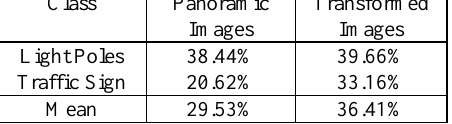
Table 4. IoU of the results from